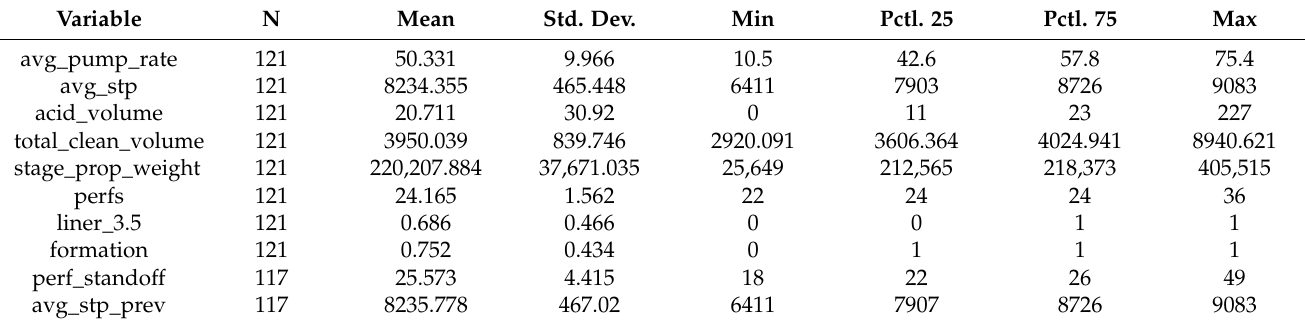
Table 1. Summary statistics for re-fracturing datasets used in this study.